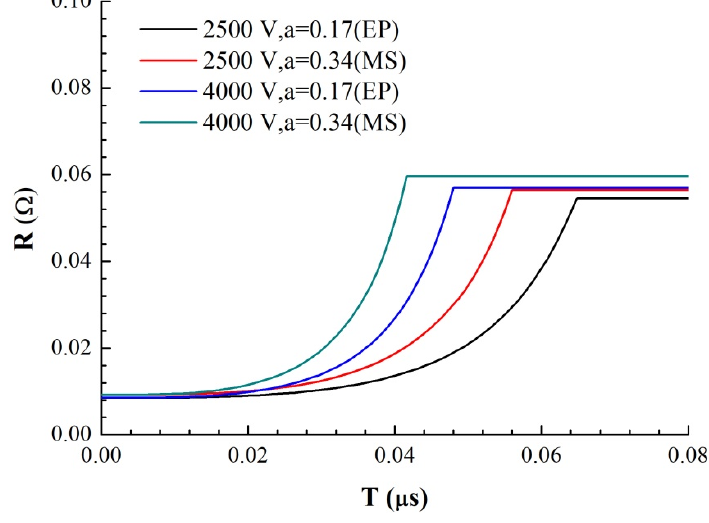
Figure 10. Theoretical simulation of the resistance curves of two samples with time under different U 0